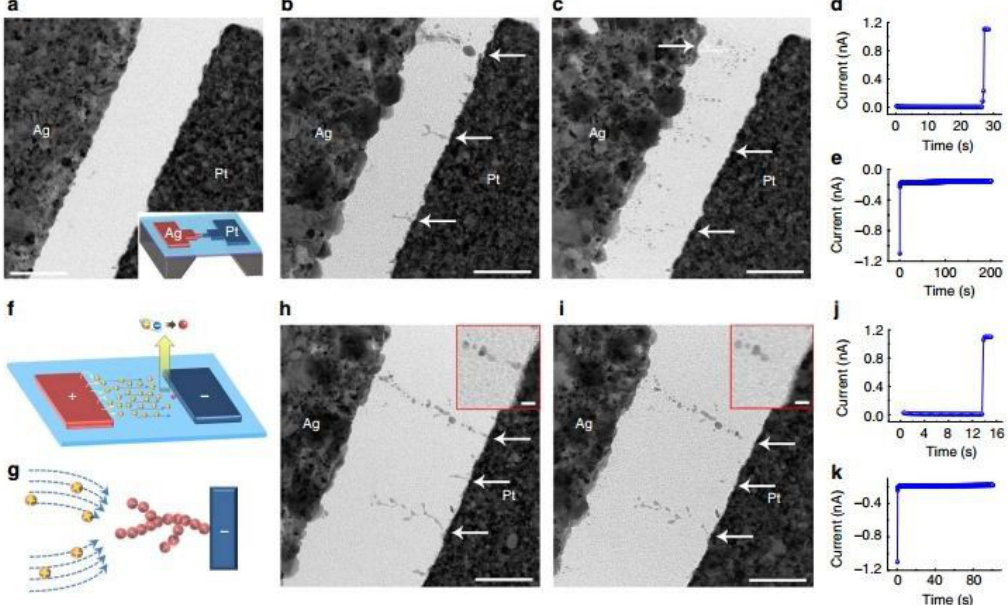
Figure 3: The phenomenon of conducting filament dynamics in SiO 2 -based ReRAM. (a) TEM image of an as-fabricated SiO 2 planar ReRAM device fabricated on SiN x membrane. Inset: schematic of SiO 2 planar ReRAM device. TEM image of the same device (b) after the forming process (c) after erasing. The arrows highlight several representative flaments. scale bar, 200 nm. ( c ) TEM image of the same device scale bar, 200 nm. Current versus time curve corresponding to (d) Forming process at 8V bias voltage (e) Erase process at − 10 V bias voltage (f) schematic of the flament growth process showing the transport and reduction of Ag cations. (g) schematic of the dendrite structure formation. ( h ) TEM image of another device with larger electrode spacing after the forming process. scale bar, 200 nm. Inset: zoomed-in image of the filament (highlighted by the upper arrow) near the dielectric/inert electrode interface. scale bar, 20 nm. (i) TEM image of the same device as in (h) after erasing. The breaking of the filaments took place at the interface of inert electrode. Current versus time curve corresponding to (j) Forming process at 10 V bias voltage (K) Erase process at − 10 V bias voltage. (Reprinted with permission from Y. Yang, P. Gao, S. Gaba, T. Chang, X. Pan and W. Lu// Nat. Commun. 3 (2012) 732 (C) 2012 Nature publishing